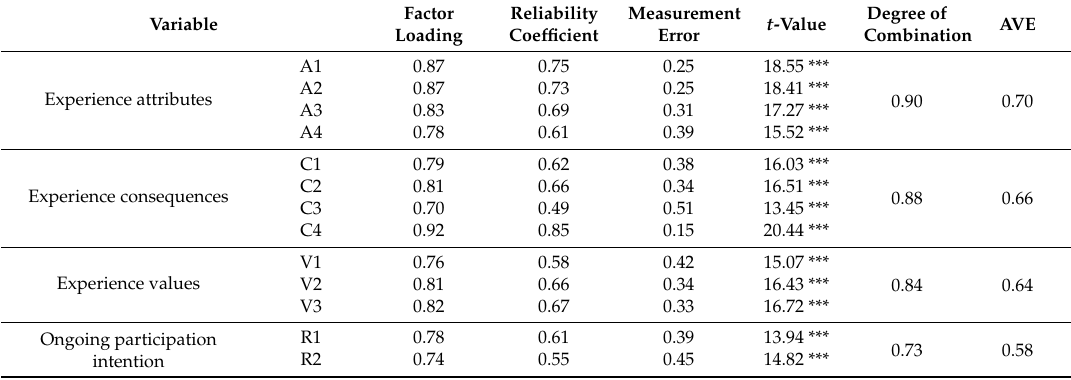
Table 4. Confirmatory factor analysis (CFA) of the variable measurement